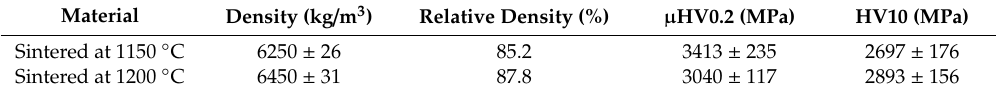
Table 3. The density, hardness and grain size data of the sintered